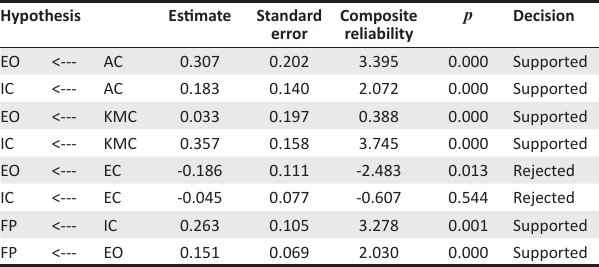
TABLE 7: Structural model goodness-of-fit assessment. Goodness-of-fit measure Chisq/ df p RMSEA Structural model RMSEA, root mean square error of approximation; CFI, comparative fit index. TABLE 8: Hypothesised relationships and regression weights. Hypothesis Estimate Standard